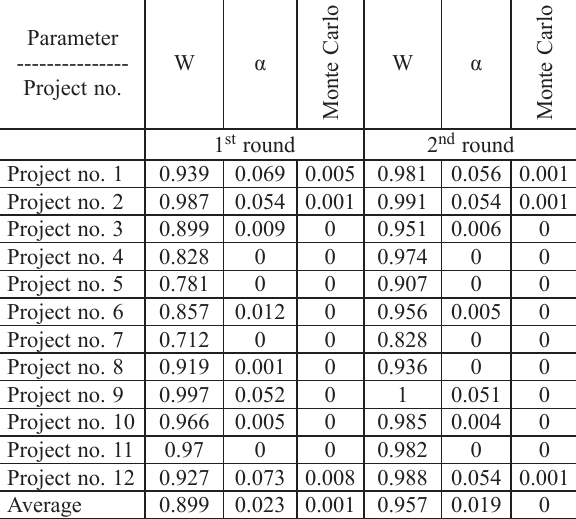
Table 5. Values of W – Kendall’s coefficient of concordance for 12 Projects in western